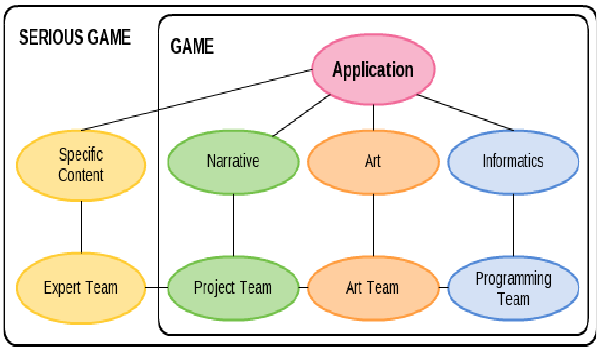
Fig. 1. Structure of the Serious Game Unified Process